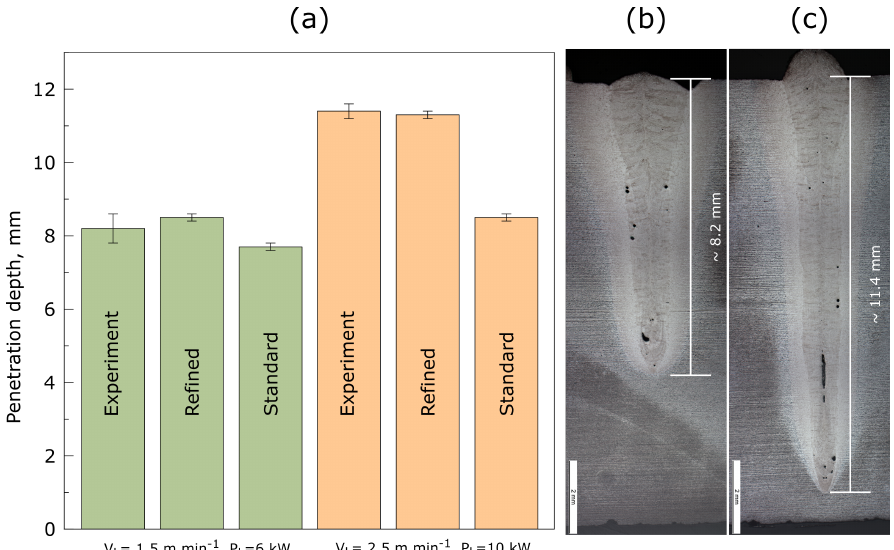
Figure 8. Calculated and measured penetration depths for LBW of 12mm thick unalloyed sheets. ( a ) Comparison between experiment, standard and virtually refined ray tracing algorithms; experi-